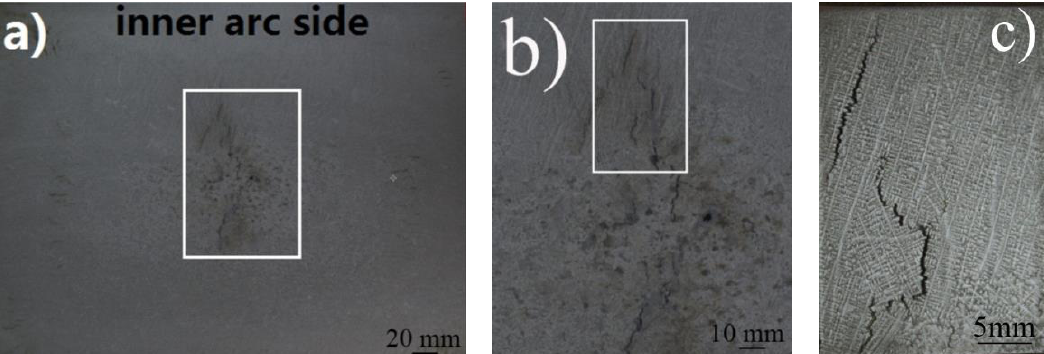
Figure 2. Macrograph of central crack on transverse section at etching print by hydrochloric acid (( a ) typical central cracks; ( b ) enlarged crack morphology; ( c ) crystal structure under optical microscope).